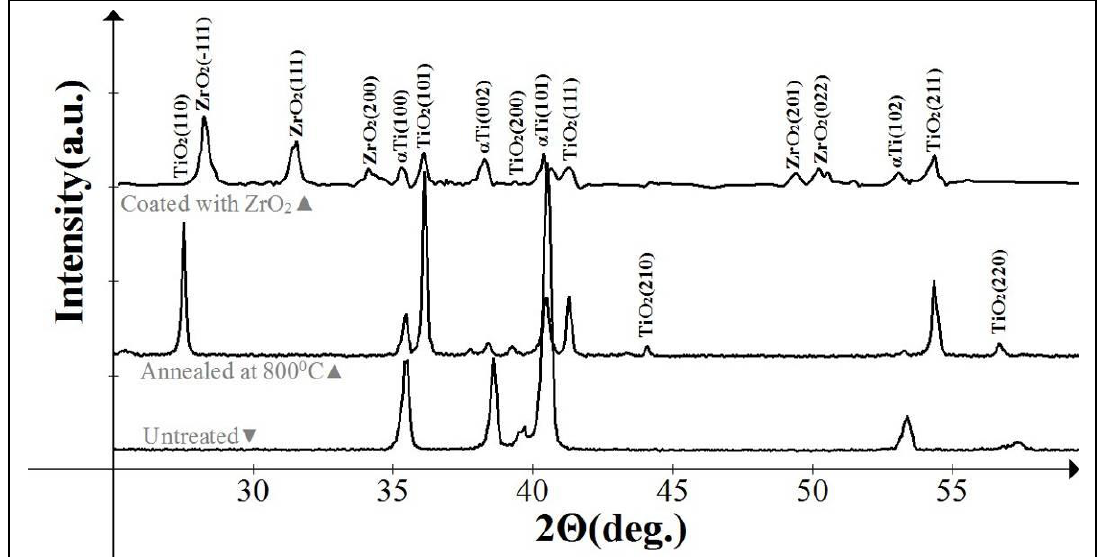
Figure 2: XRD patterns of untreated, annealed and coated samples.